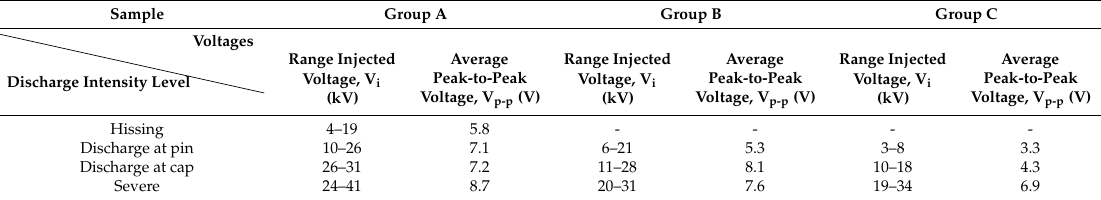
Table 13. Injected voltage and average peak-to-peak voltages of the UV signals for wet insulators conditions with medium contamination level.